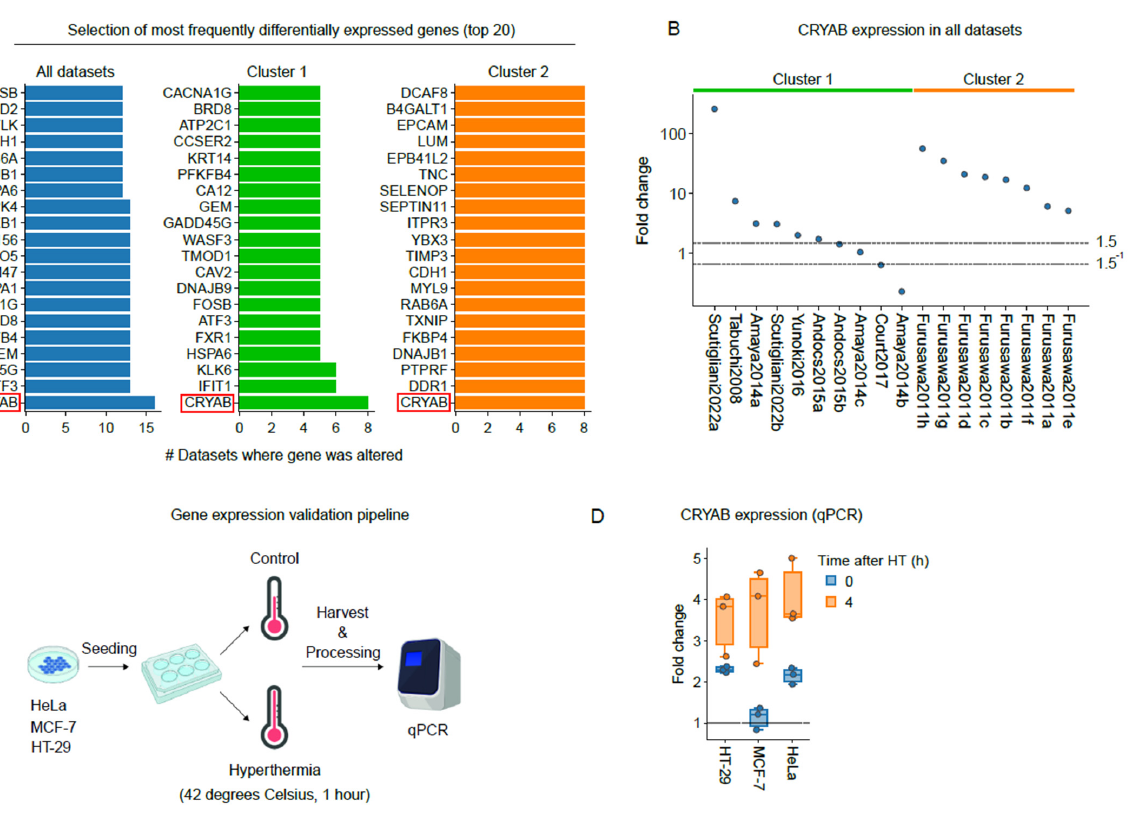
Figure 4. Leading edge analysis reveals commonalities in gene expression profiles. ( A ) Leading edge analysis based on hallmark gene sets that were found to be enriched in the overrepresentation analysis. The analysis was carried out on all datasets, cluster 1, and cluster 2. Genes that appear in a hallmark gene set are marked in blue. ( B ) Top 20 most found genes in the leading edge analysis of all datasets, cluster 1, and cluster 2. ( C ) Overlap in most frequently overexpressed genes that were found at least three times in cluster 1, and 4 times in cluster 2. ( D ) Result of the overrepresentation analysis for hallmark gene sets that used the eight overlapping genes between the clusters, as shown in (C), as input.